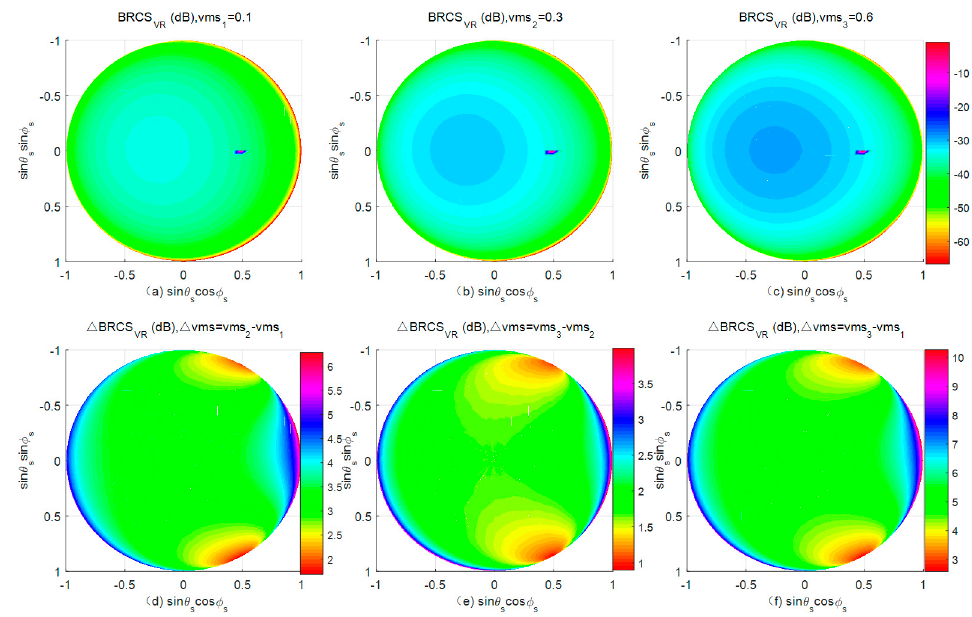
Figure 9. BRCS for different soil moisture contents ( a – c ) and the BRCS differences for different soil moisture differences ( d – f ) at VR polarization.